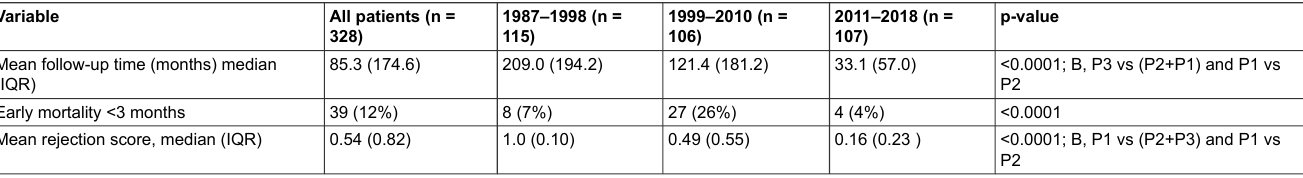
Table 4: Follow-up and outcome.